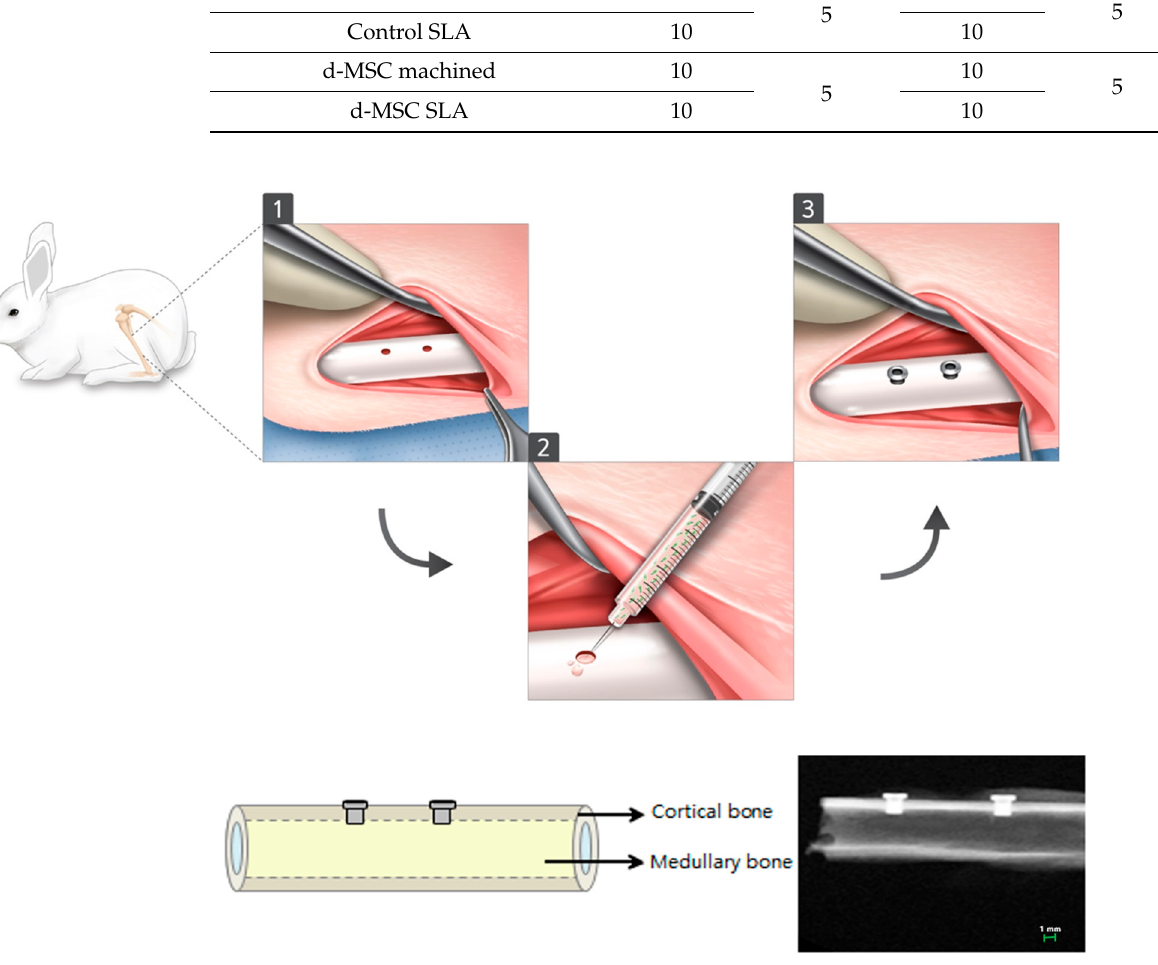
Figure 1. Surgical procedure used in this study.